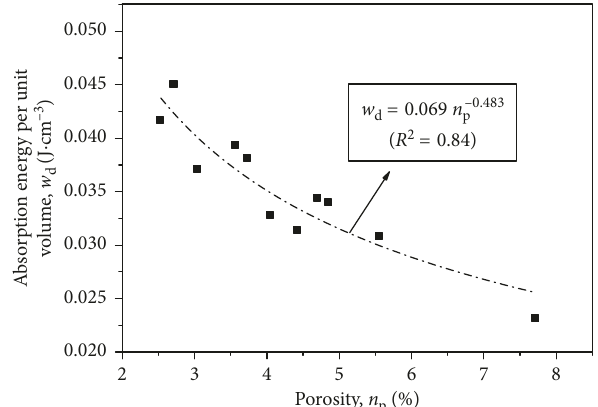
Figure 11: Relationship between porosity and absorption energy per unit volume.